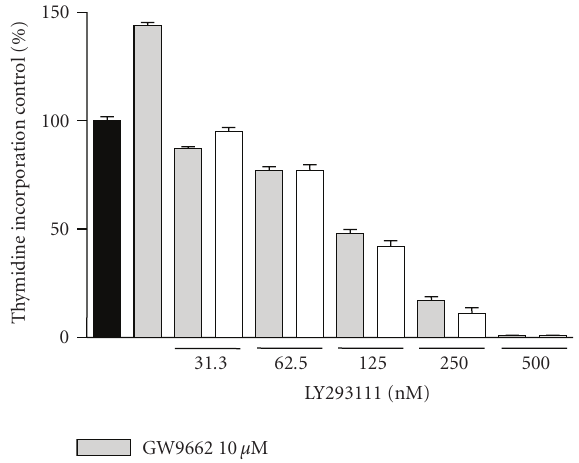
Figure 3: E ff ect of a PPAR γ receptor antagonist, GW9662 on the inhibition of proliferation induced by LY293111 in AsPC-1 human pancreatic cancer cells after 24 hours of treatment. These cells express both the PPAR γ receptor and LTB 4 (BLT1 and BLT2) receptors. While GW9662 alone was able to significantly increase thymidine incorporation, it was not able to block the inhibitory e ff ect of di ff erent concentrations of